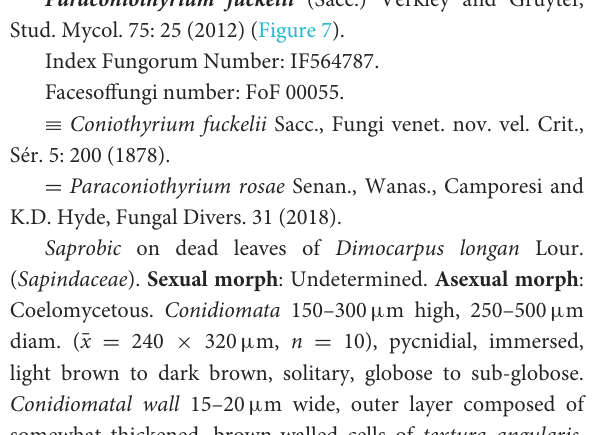
of Cinnamomum camphora in Japan (Nakashima et al.,